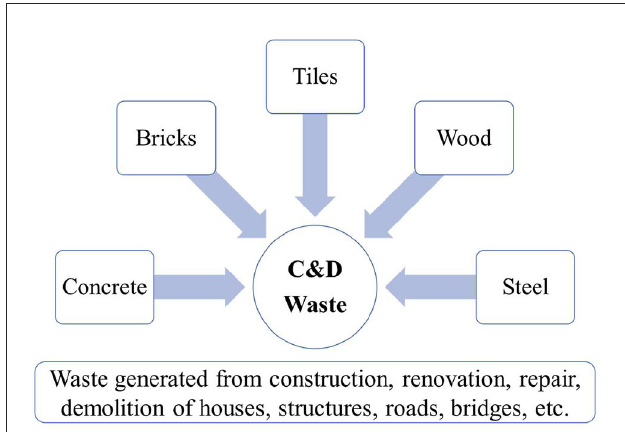
FIGURE1 C&D wastes major